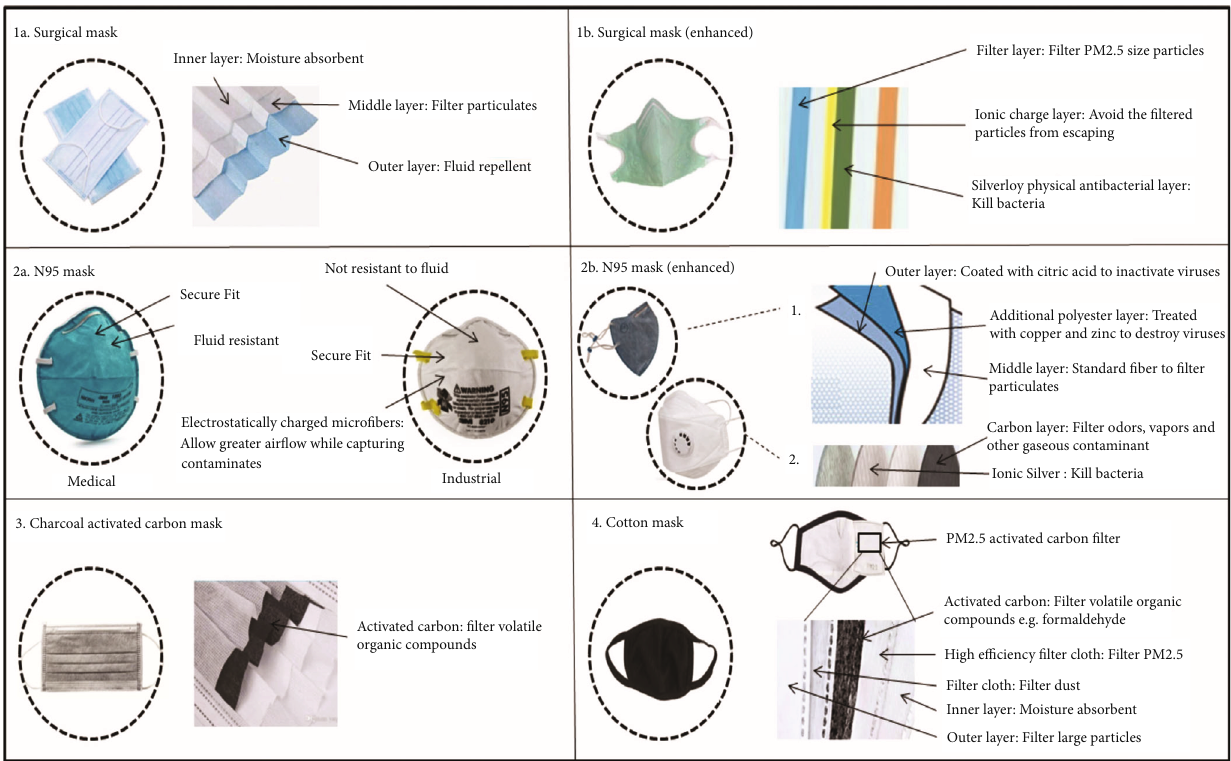
Figure 3: Composition and function of di ff erent layers in masks